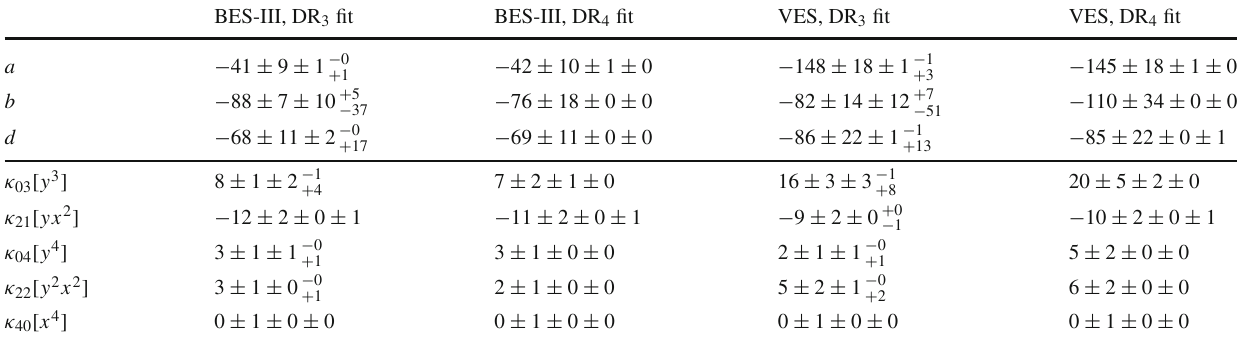
Table 4 Dalitz-plot parameters obtained from a Taylor expansion of are to be compared with Table 1. The first error is the fit uncertainty, the the dispersive amplitude according to Eq. (33), using the best fittingval- second (third) error is the systematic uncertainty due to the ππ ( πη ) ues of the subtraction constants for the BES-III and VES data samples phase input as input. All values are given in units of 10 − 3 . The values shown here BES-III, DR 3 fit BES-III, DR 4 fit VES, DR 3 fit VES, DR 4